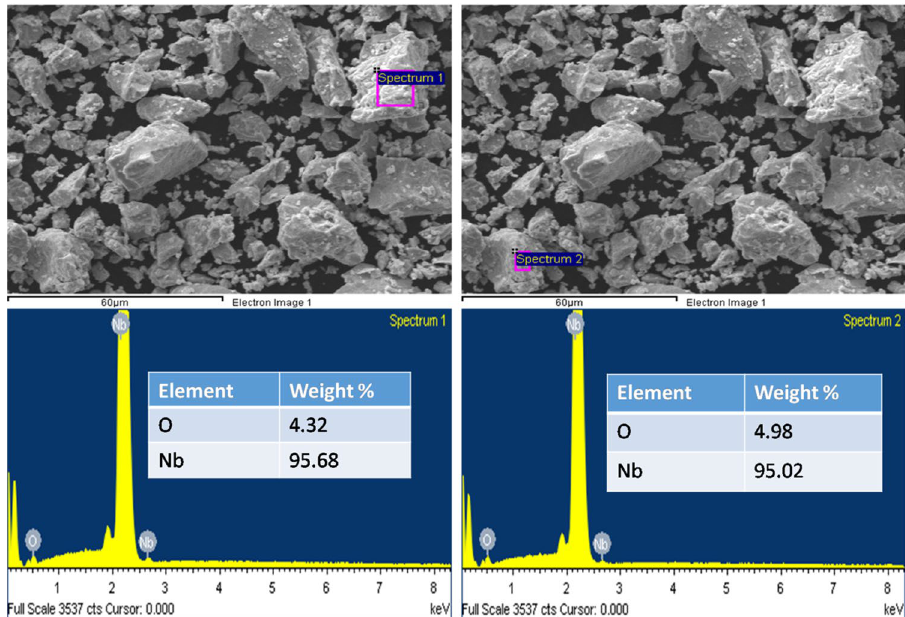
Figure 1. shows the SEM and EDS images of the starting powders.